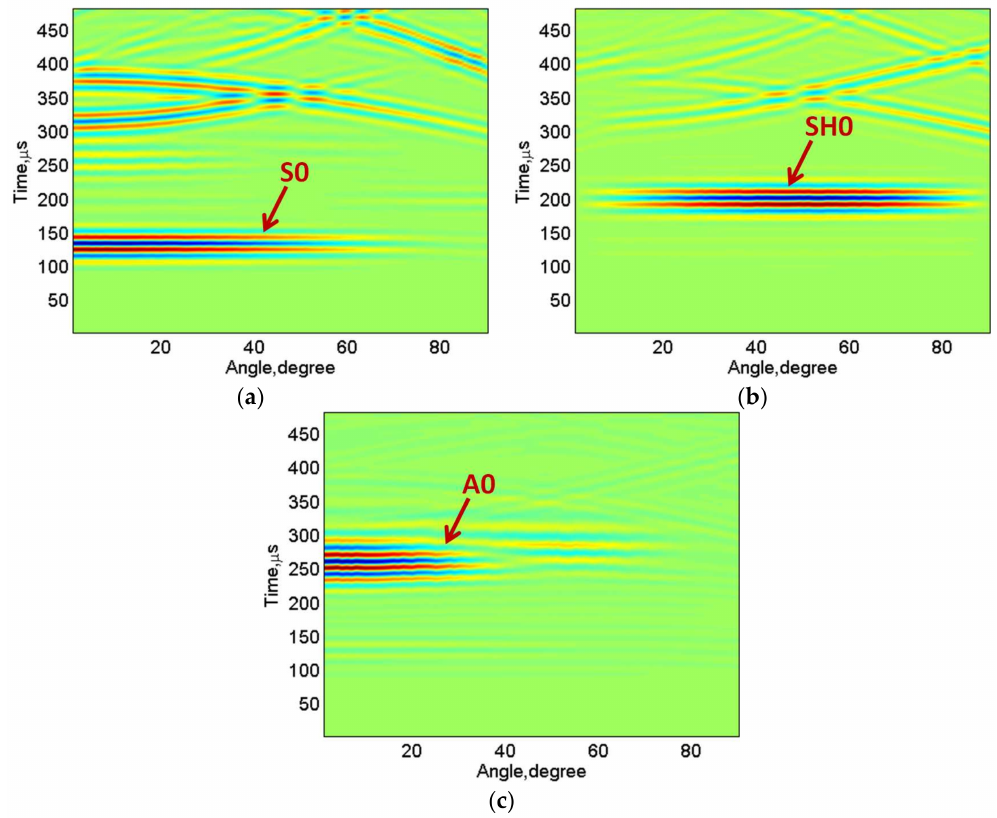
Figure 7. The B-scan images of particle velocity components in the direction of propagation (the S0) ( a ), perpendicular to the direction of propagation (the SH0) ( b ), and in the direction of propagation (the A0) ( c